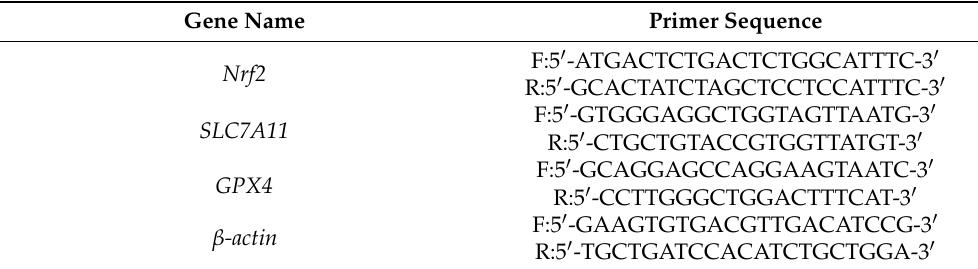
Table 1. List of primers employed for